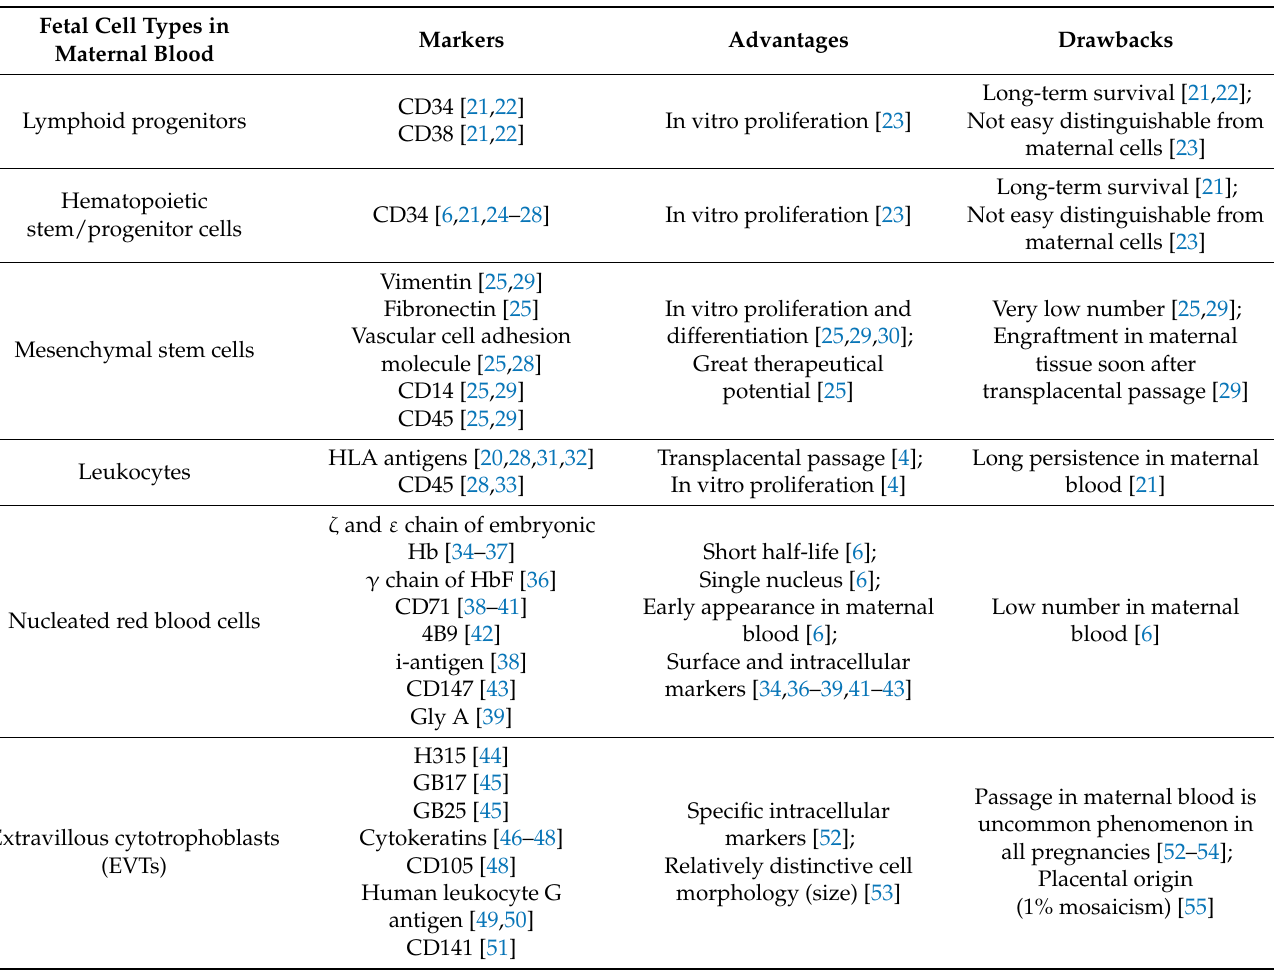
Table 1. Fetal cell lines isolated from maternal peripheral blood and markers most commonly applied for validation of